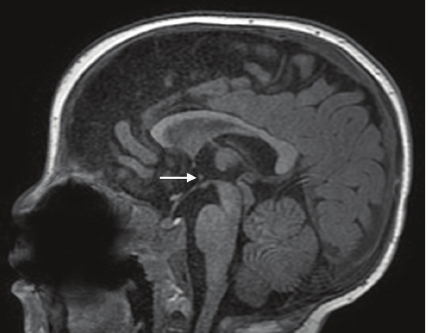
Figure2:CoronalFIESTA-C(repetitiontimemsec/echotime,10/4) showingahorizontalinterhypothalamicparenchymalbandcrossing the third ventricle (arrow).